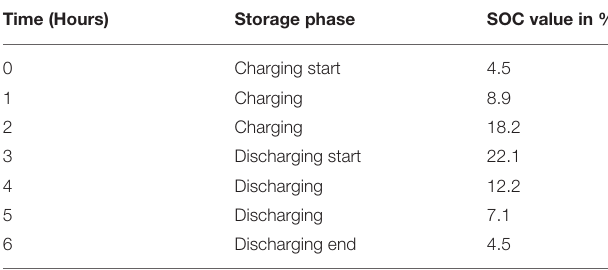
TABLE 3 | SOC output for 24